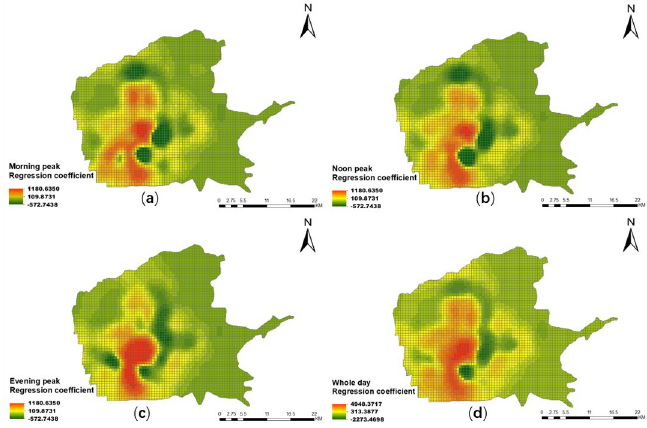
Fig 12. Spatial distribution of coefficient of the mixed degree of urban functions in different periods on weekdays. (a) Morning peak; (b) noon peak; (c) evening peak; (d) overall peak.